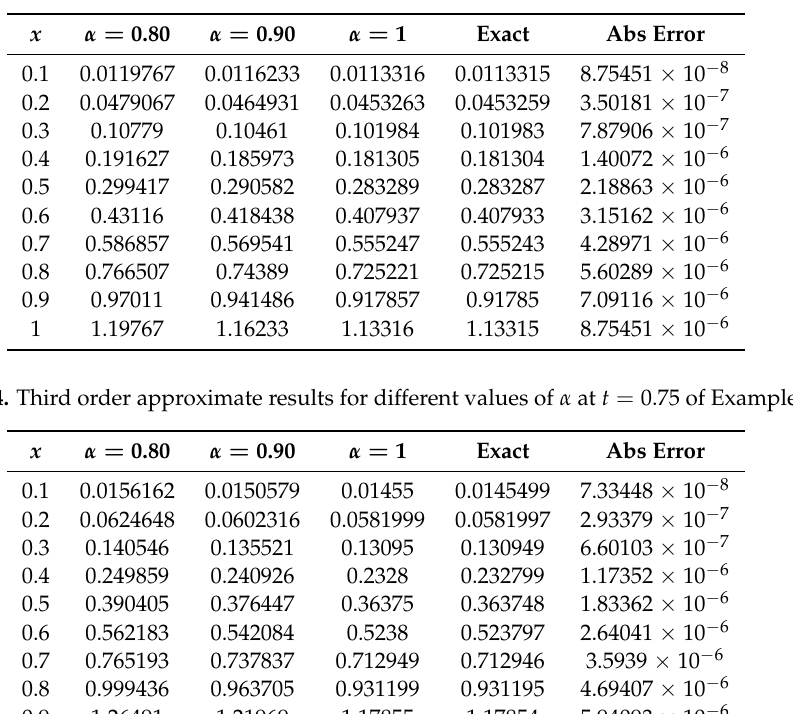
Table 3. Third order approximate results for different values of α at t = 0.25 of Example 1.